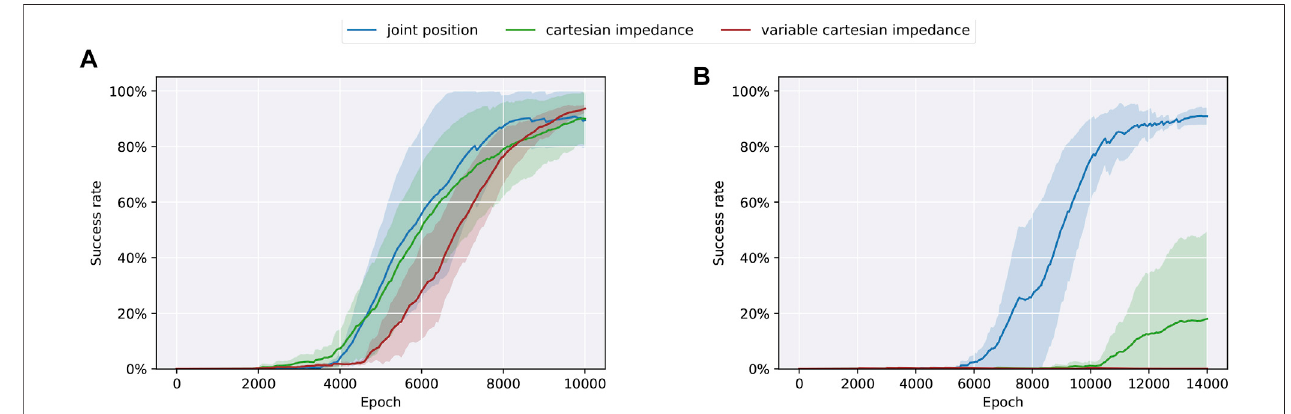
FIGURE 3 | Training results in simulation using different action spaces (joint position control, Cartesian impedance control, and variable Cartesian impedance control) on the task of dual-arm peg-in-hole assembly separated for different clearances [2 mm (A) and 0.5 mm (B)